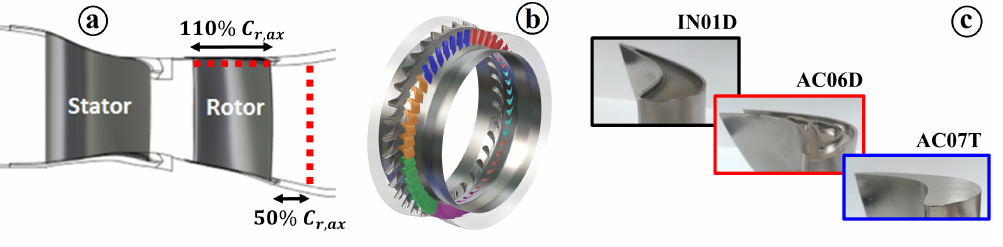
Figure 1. Test article: HP stage ( a ); rainbow rotor setup ( b ); and optimized rotor tips ( c